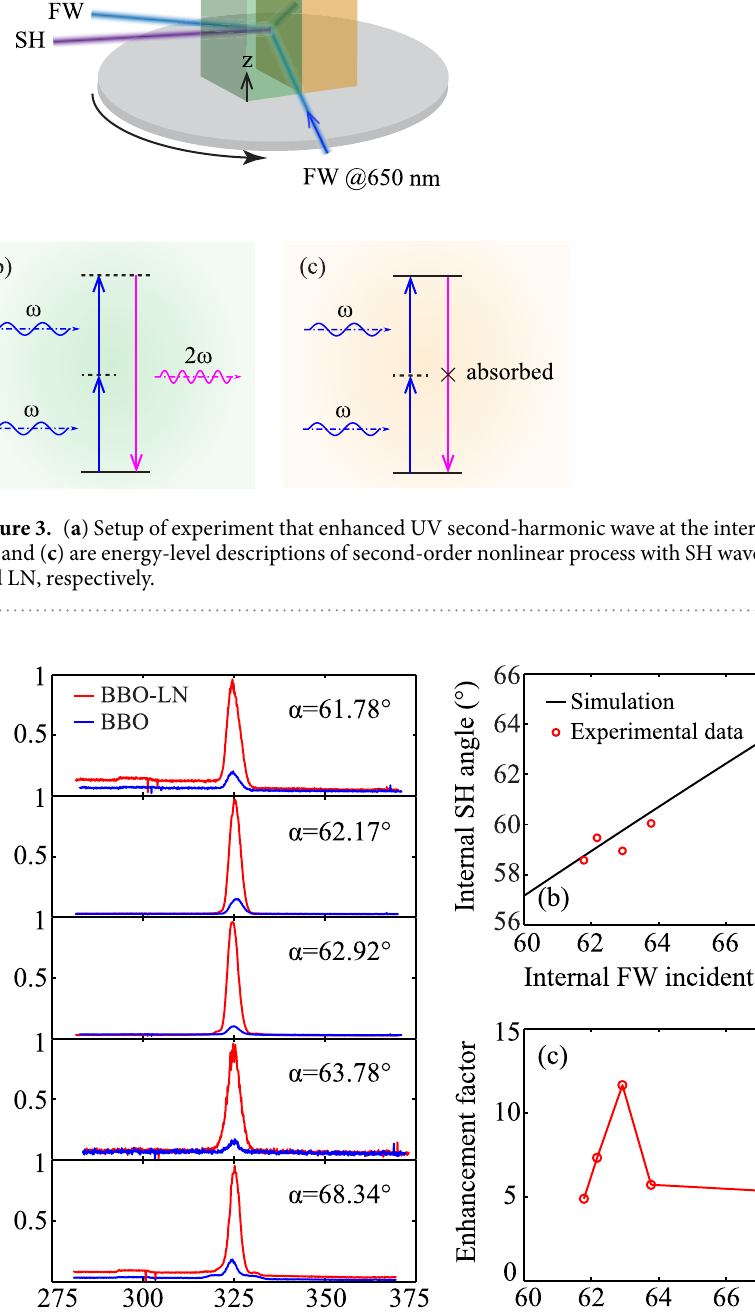
the BBO boundary. It verifies from the coupled wave equation. And in microcospic perspective, the nonlinear polarization wave motivated by FW and propagating along the interface is the oscillation of electric dipoles. In the BBO side, the oscillation of electric dipoles radiate SH at the phase-matching angle [see Fig. 3(b)]. However, in LN side, the SH at 325 nm is absorbed corresponding to inherent frequency of substance. Figure 3(c) describes